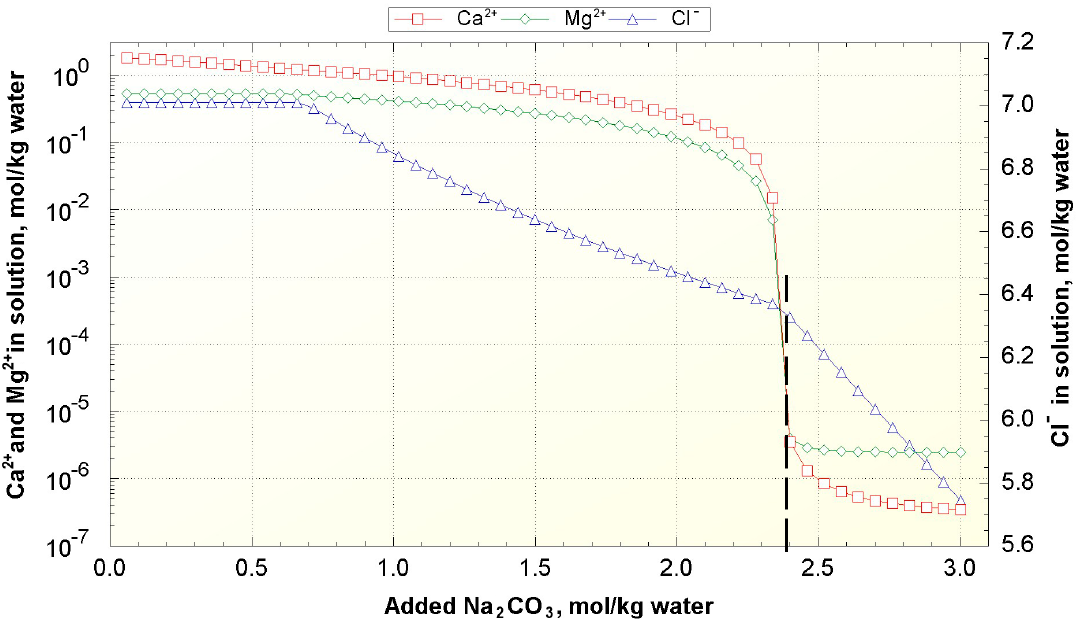
Figure 6. Change of Ca 2+ , Mg 2+ , and Cl − molalities in geothermal brine with the addition of Na 2 CO 3 (calculation with PHREEQC).